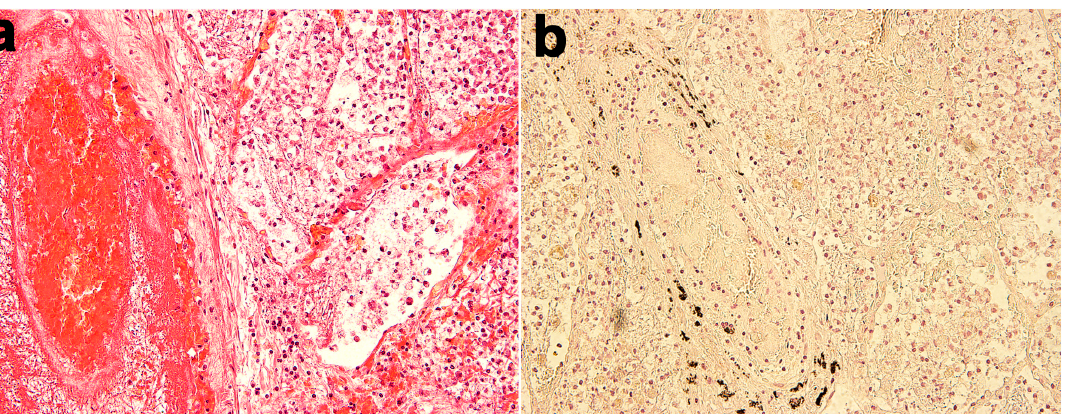
Figure 3. ( a ) H&E staining (20×) showing unilateral diffuse alveolar damage with a focus on a microthrombus and surrounding lung tissue characterized by severe organizing pneumonia. ( b ) Anti-COVID nucleocapsid antibody (anti Coronavirus-FIPV3-70 Santa Cruz Biotechnology, Inc, Dallas, TX, USA) positivity (data obtained and collated in the course of personal death from COVID-19 infection case, which was negative both to serological and swab tests).